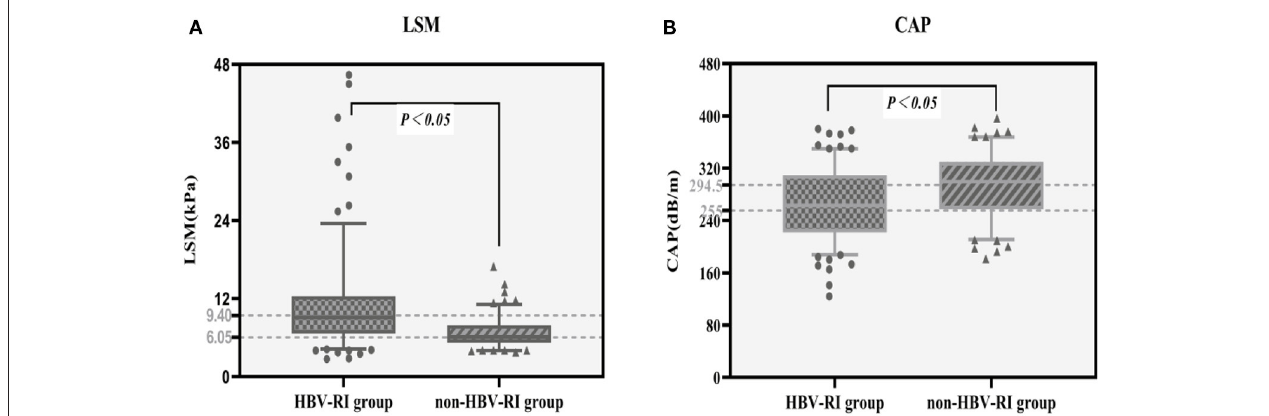
FIGURE 7 | LSM and CAP results between the HBV-RI group and the non-HBV-RI group. (A) LSM between the HBV-RI group and the non-HBV-RI group. (B) CAP between the HBV-RI group and the non-HBV-RI group. HBV-RI group, HBV-related inflammation group; non-HBV-RI group, non-HBV-related inflammation group; LSM, Liver stiffness measurement; CAP, controlled attenuation parameter. The median value of LSM in the HBV-related inflammation group was 9.40 KPa, whereas in the non-HBV-related inflammation group was 6.05 U/L, and the difference was significant ( P < 0.05); The median value of CAP in the HBV-related inflammation group was 255 dB/m, while in the non-HBV-related inflammation group was 294.5 dB/m, which was statistically significant ( P < 0.05).